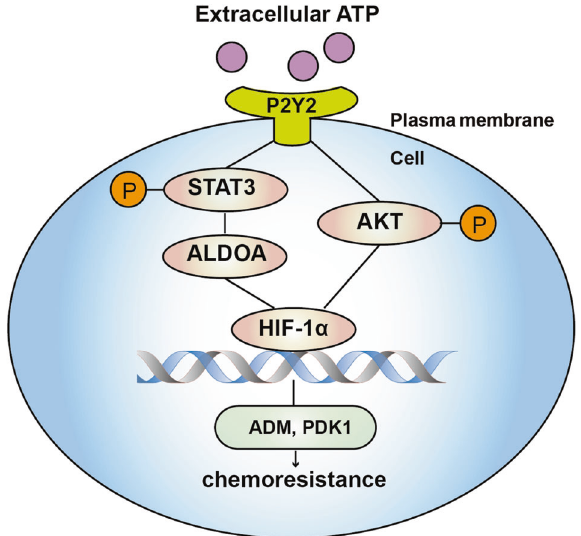
Fig. 8 A proposed model of the ATP-HIF-1 α signaling. Extracellular ATP could stimulate STAT3-ALDOA and AKT signaling via P2Y2 receptor and then regulate HIF-1 α as well as HIF-1 α target genes, among which ADM and PDK1 mediate ATP-driven